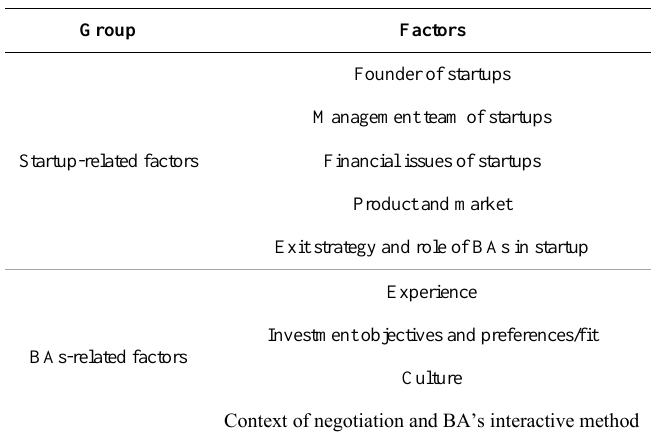
Table 1. Factors affecting angel